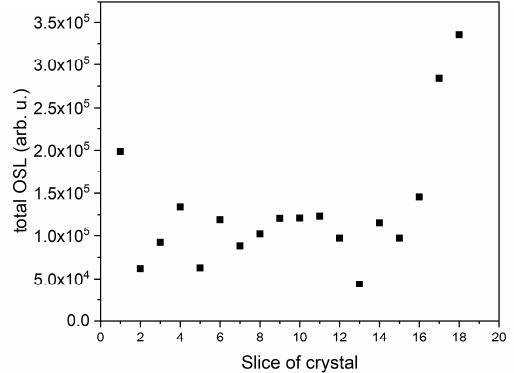
Figure 6. OSL signal of LMP doped with 1.2-mol% Tm and 10-mol% B integrated from 0 to 300 s for all OSL curves. The samples were irradiated with 0.2 Gy of beta rays in a Risø reader. Slice of ure 1.